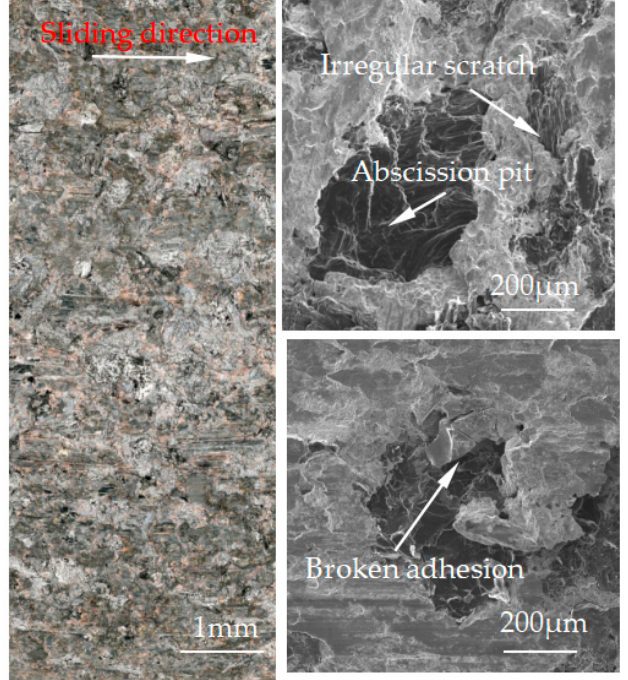
Figure 10. Surface morphology of the pad material after intermittent braking at an ambient tempera- ture of − 20 °C.